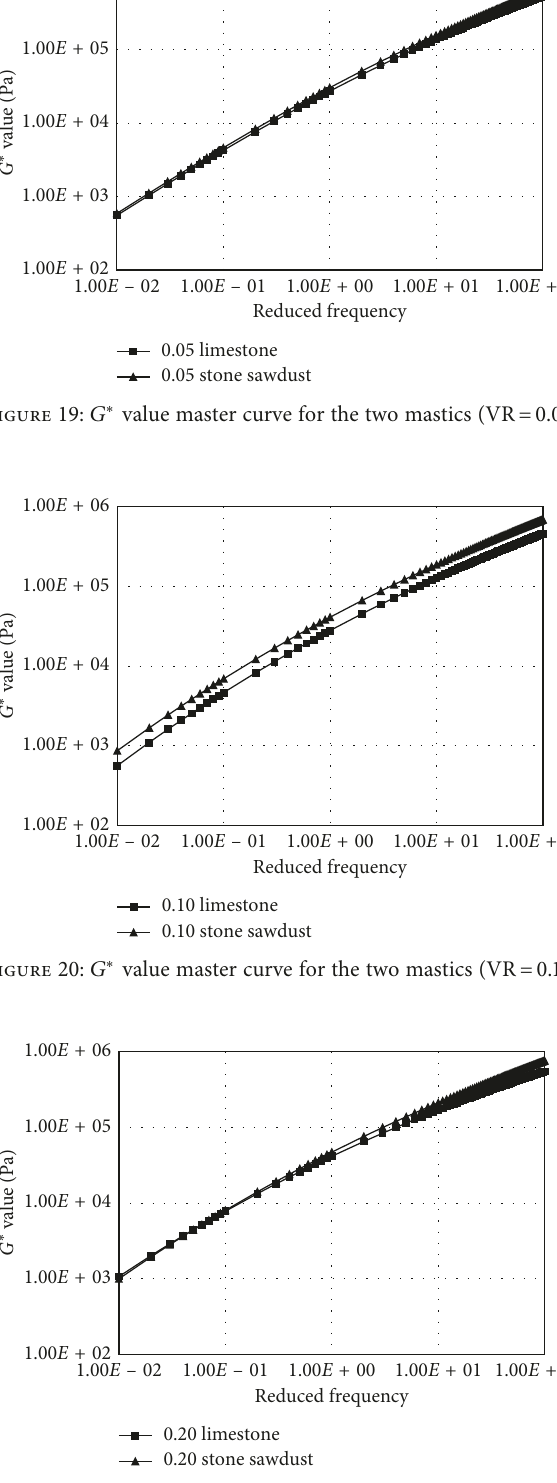
Figure 21: G value master curve for the two mastics (VR ∗